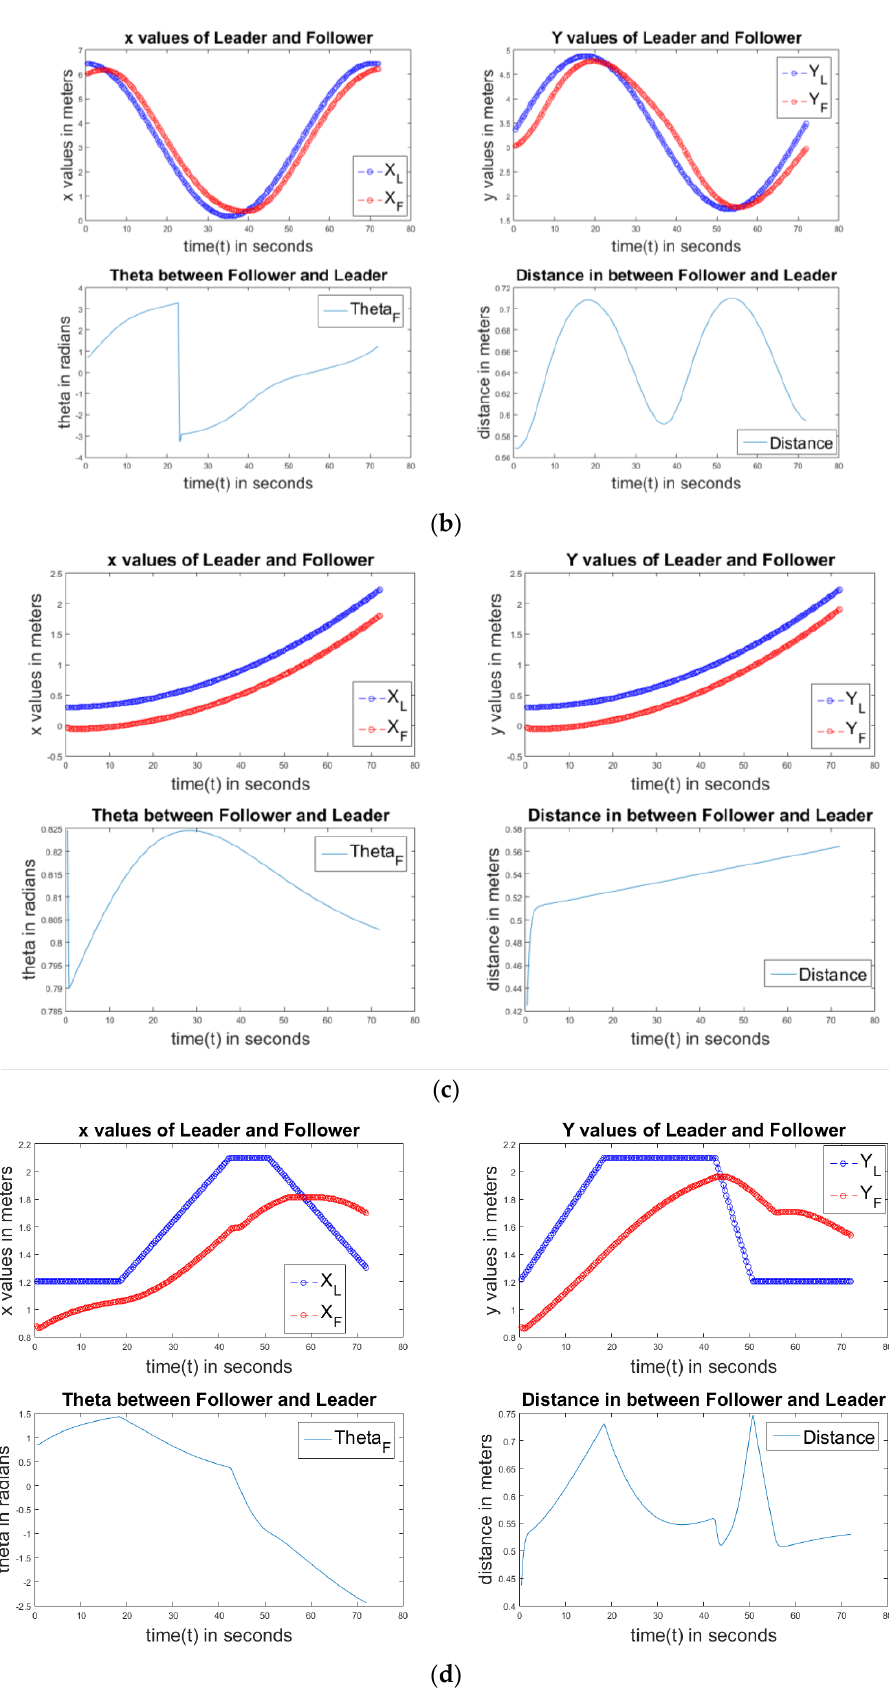
Figure 13. ( a ) PID controller of a circle; ( b ) PID controller of an ellipse; ( c ) PID controller of a line; ( d ) PID controller of a square.